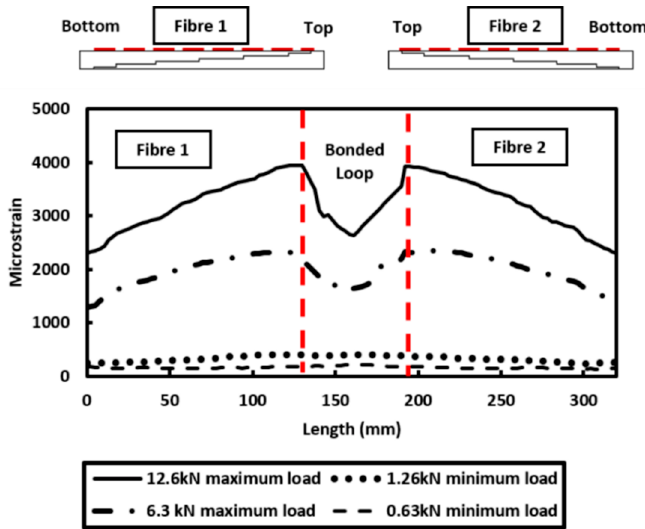
Figure 7. Distributed strain measurement along the bonded loop of fibre.